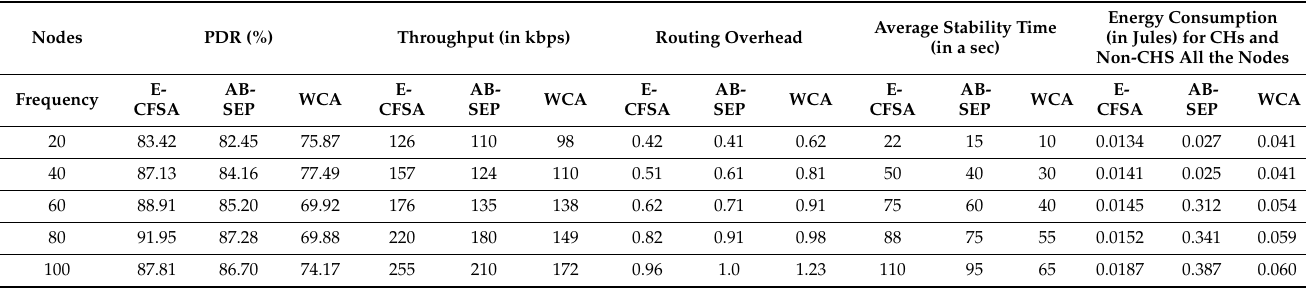
Table 7. Simulation results (Impact of Network Size).